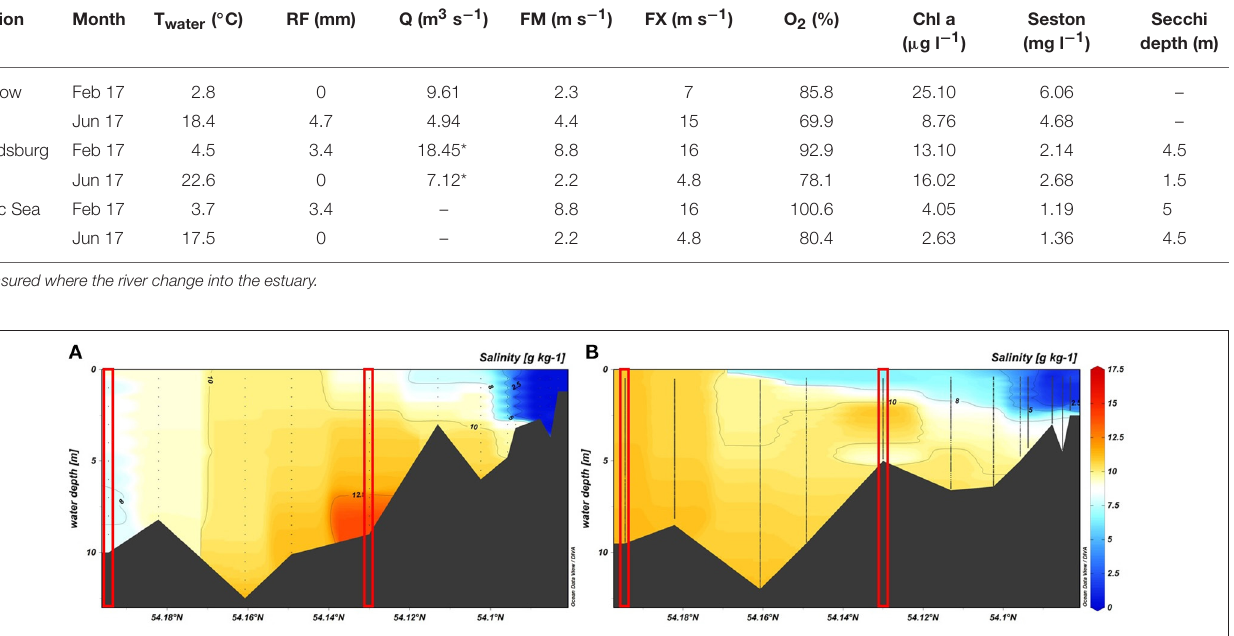
accurately by the common and standardized molybdenum blue colorimetric